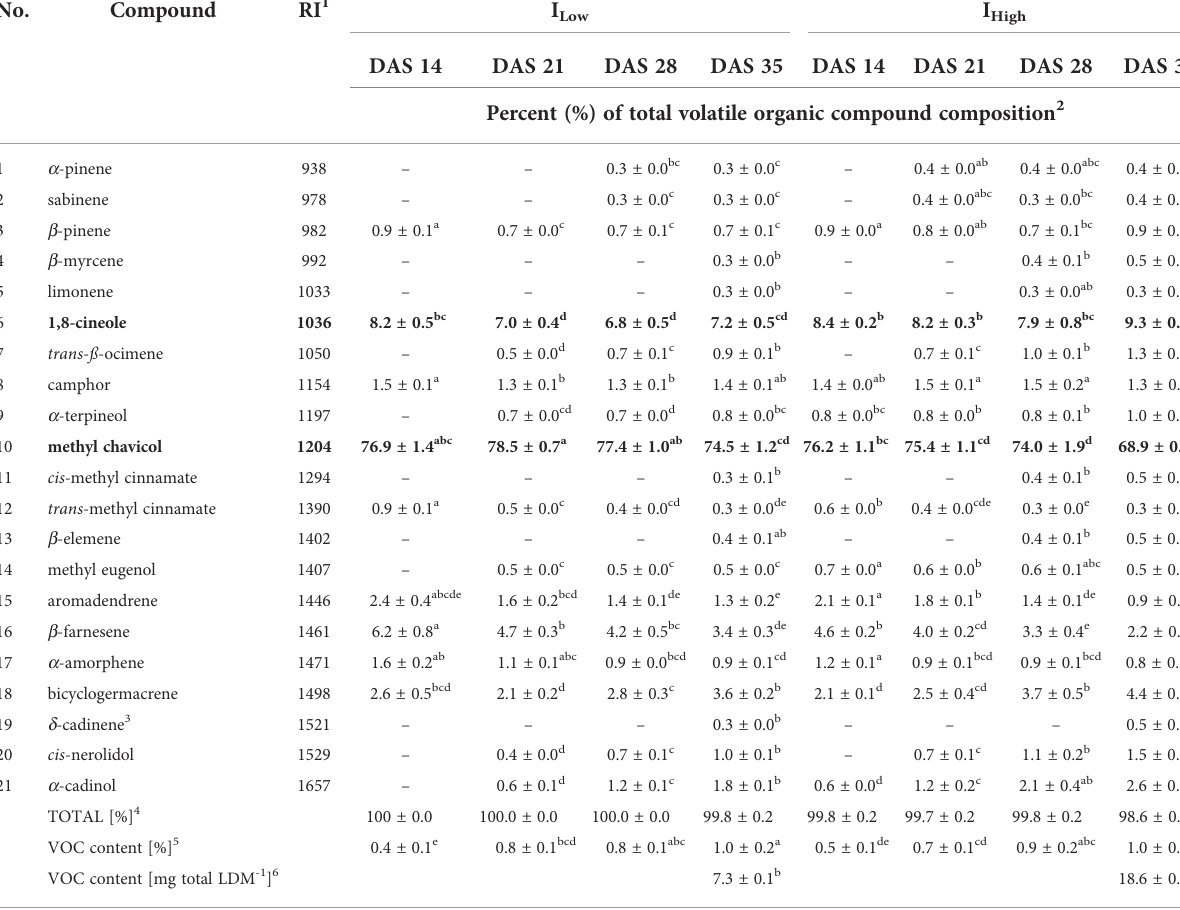
TABLE 3 Relative abundance of major volatile organic compounds identi fi ed in the leaves of O. basilicum L. cv. ‘ Anise ’ as affected by LED light intensity treatments over time.